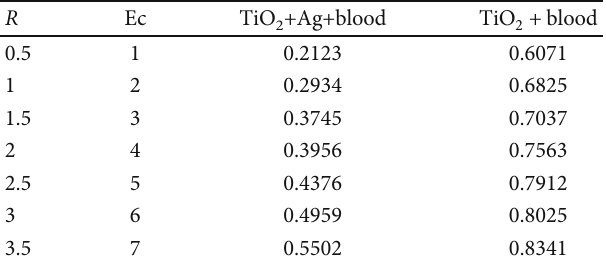
Table 2: Inspiration of R and Ec on Nusselt number.